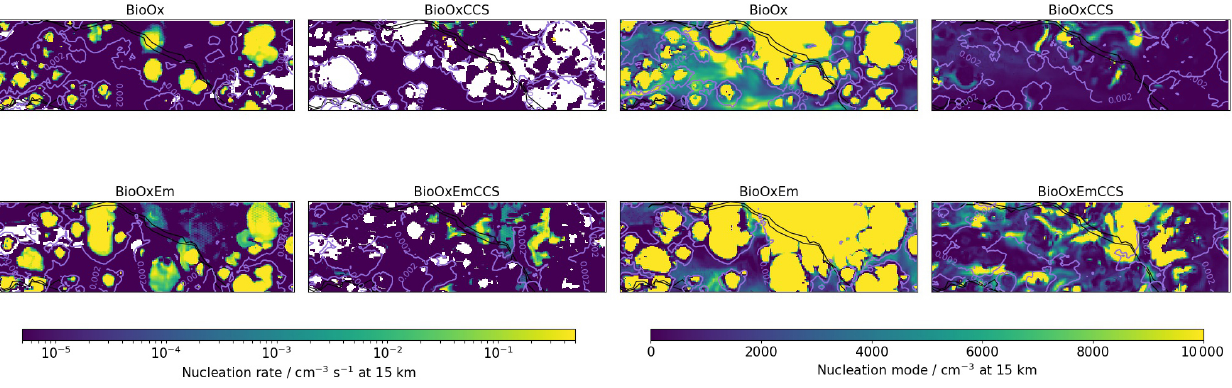
Figure 6. Maps of regional domain nucleation rate (left) and nucleation mode aerosol number concentrations (right) in the simulations BioOx, BioOxCCS, BioOxEm and BioOxEmCCS at a height of 15km and at 16:00UTC on 17 September 2014. Contours highlight the locations of clouds and are drawn where the cloud water content is equal to 0.002gkg − 1 . The white areas in the nucleation rate maps have zero values and cannot be specified by a log-scale